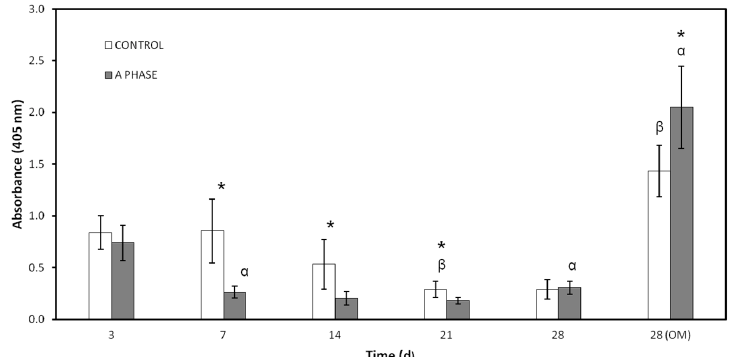
Figure 4. Alkaline phosphatase activity of the cells seeded in indirect contact with A phase compared to plastic used as control. (*) denotes significant differences ( p < 0.05) between A phase and control at the same experimental time; ( α ) denotes significant differences ( p < 0.05) between different experimental times obtained for control samples; ( β ) denotes significant differences ( p < 0.05) between different experimental times obtained for cells growing on Nurse’s A-phase scaffolds.